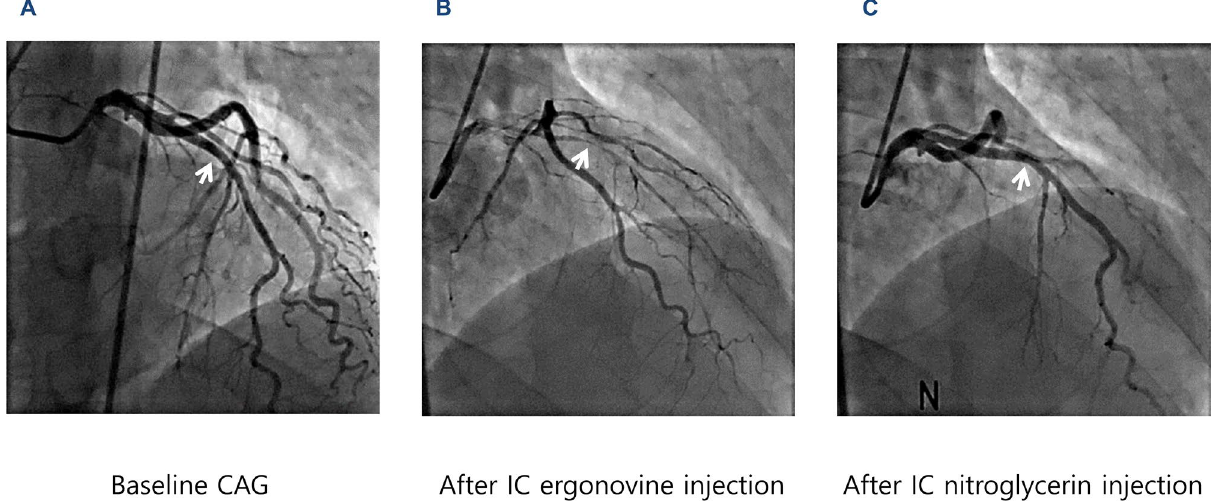
Figure 6. A representative case. ( A ) Baseline coronary angiography shows no significant stenosis in the left anterior coronary artery (LAD). ( B ) After IC ergonovine injection, significant narrowing occurs in the mid LAD. ( C ) After IC nitroglycerine injection, the previous significant narrowing in the mid LAD is resolved. The white arrow indicates the sites of maximal diameter change after IC ergonovine. Abbreviations: CAG